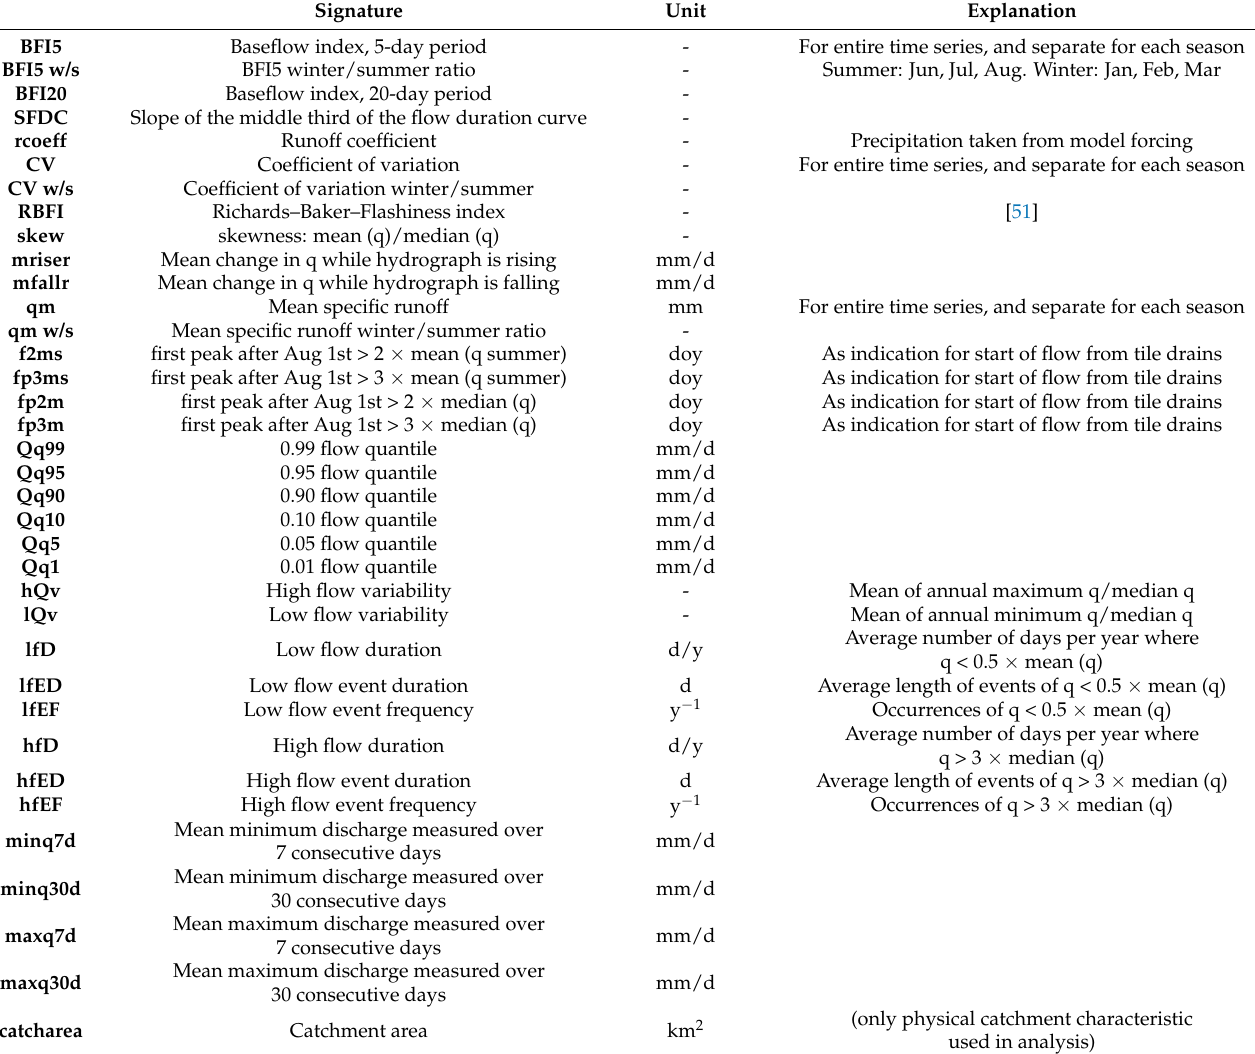
Table 1. List of hydrological signatures used as explanatory variables in machine learning